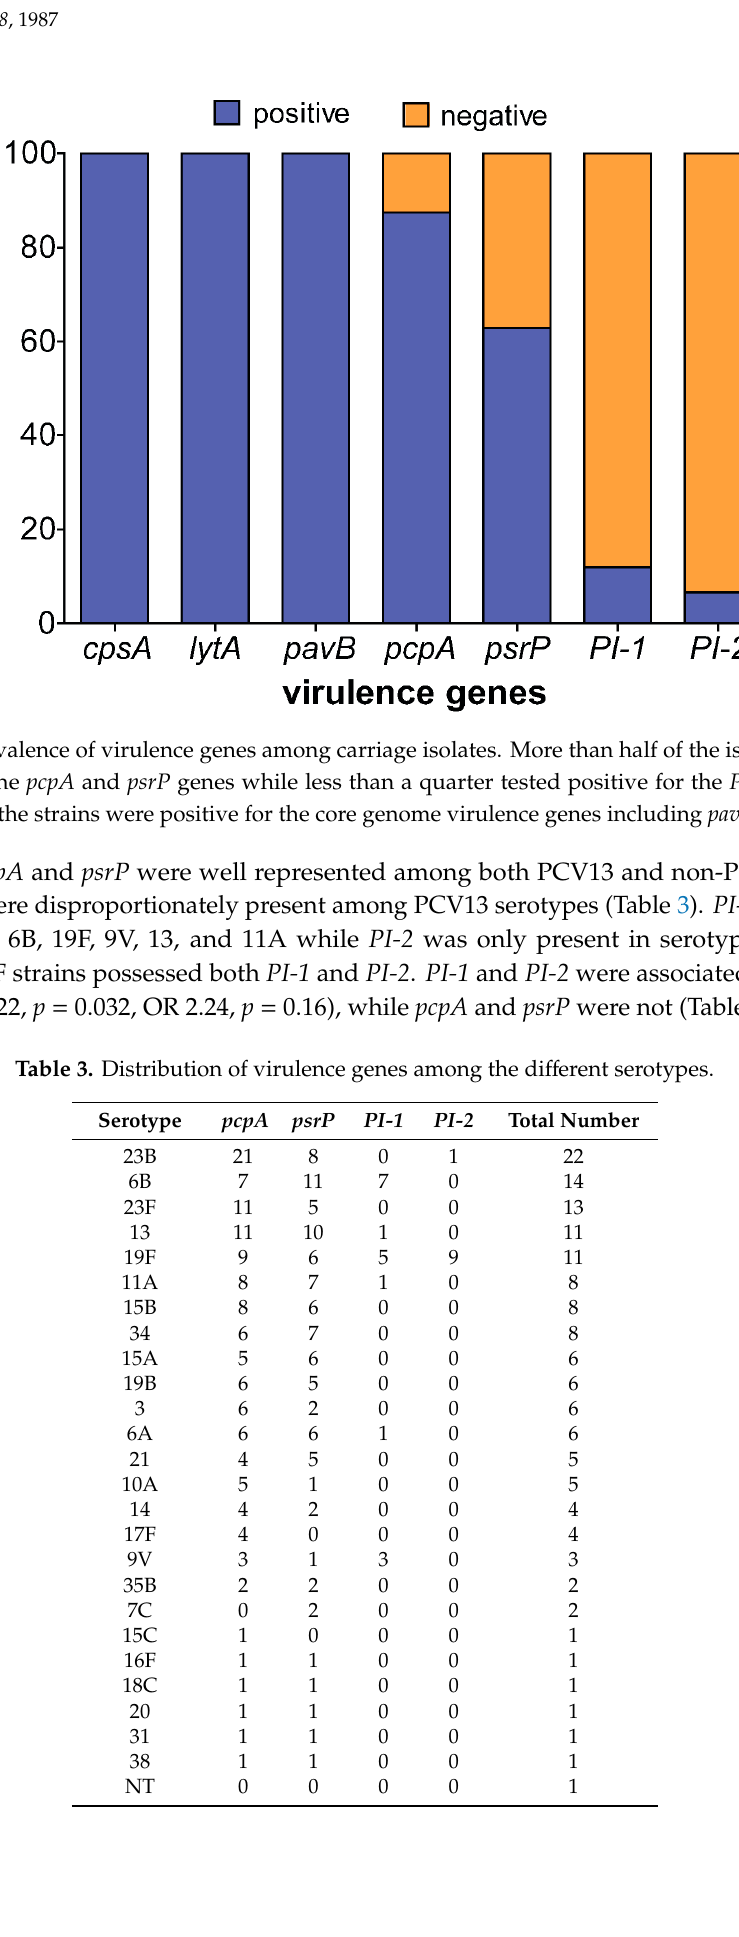
Table 3. Distribution of virulence genes among the different serotypes.